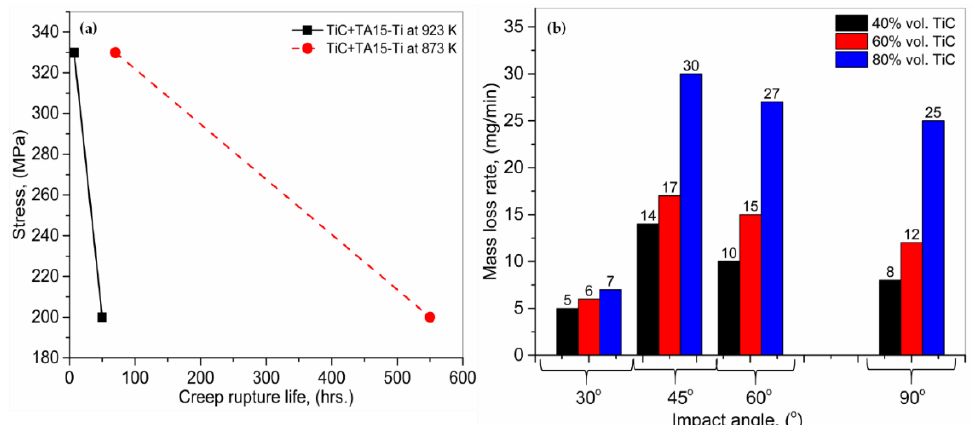
Figure 13. ( a ) Creep behavior of TiC + TA15-Ti MMCs, and ( b ) erosion rates for 40, 60, and 80 (vol.%) TiC + H13 tool steel MMCs at various impact angles; based on the data provided in Ref. [147,148].